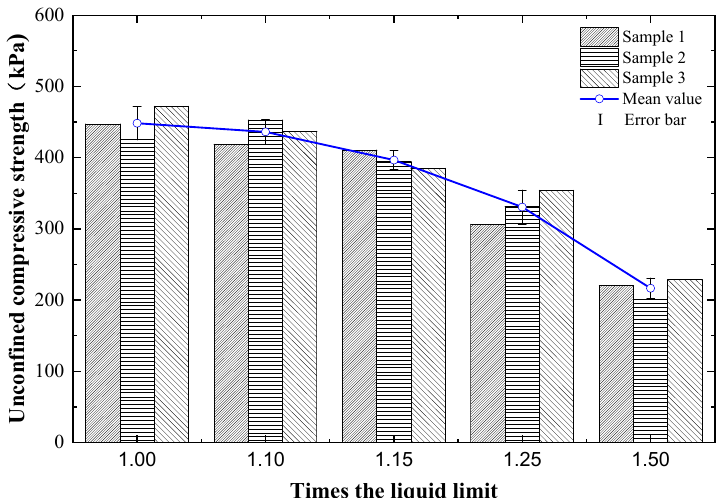
Figure 4. Compressive strength variations of cement- and steel-slag-stabilized dredged soils with different moisture contents. 3.3. Influence of the Particle Size of Steel Slag on the Compressive Strength of Dredged Soils Stabilized by Cement and Steel Slag Cikmit et al. [20] pointed out that the compressive strength was significantly affected by the maximum particle sizes of steel slag. The smaller the maximum particle sizes of steel slag, the better the mechanical performance that could be achieved. Figure 5 demon- strates the compressive strength changes of dredged soils stabilized by cement and steel slag with the different maximum particle sizes of steel slag, in which the ratio of steel slag to cement was 6:9. It can be observed that the compressive strength of dredged soils sta- bilized by cement and steel slag increased with the decrease of the maximum particle size of steel slag overall. This may be because the smaller the particle size of steel slag was, the larger the total specific surface area of steel slag was, the higher the activity of fine steel slag particles was, and the higher the pozzolanic reaction efficiency of steel slag particles with cement would be. The addition of steel slag promoted cement hydration, generating more gels such as calcium silicate hydrate (CSH) and calcium aluminate hydrate (CAH) during hardness so that the compressive strength of dredged soils stabilized by cement and steel slag was significantly improved.